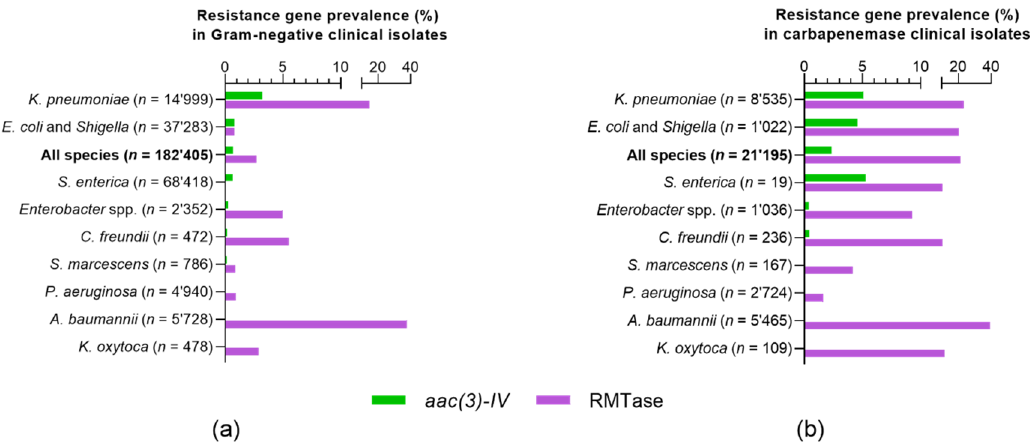
Figure 1. Genomic prevalence of the aac(3)-IV gene in Gram-negative clinical isolates in comparison to RMTase resistance genes. ( a ) Gene-annotation analysis of 182,405 clinical-isolate genomes deposited in NCBI National Database of Antibiotic Resistant Organisms (NDARO) on 24 June 2020.